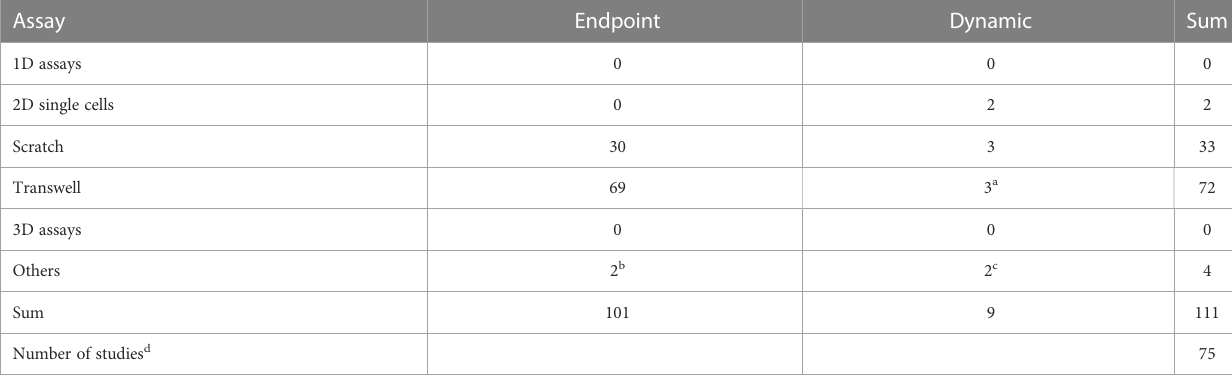
TABLE 2 The number and type of in vitro assays used to analyze MACC1-dependent migratory effects.